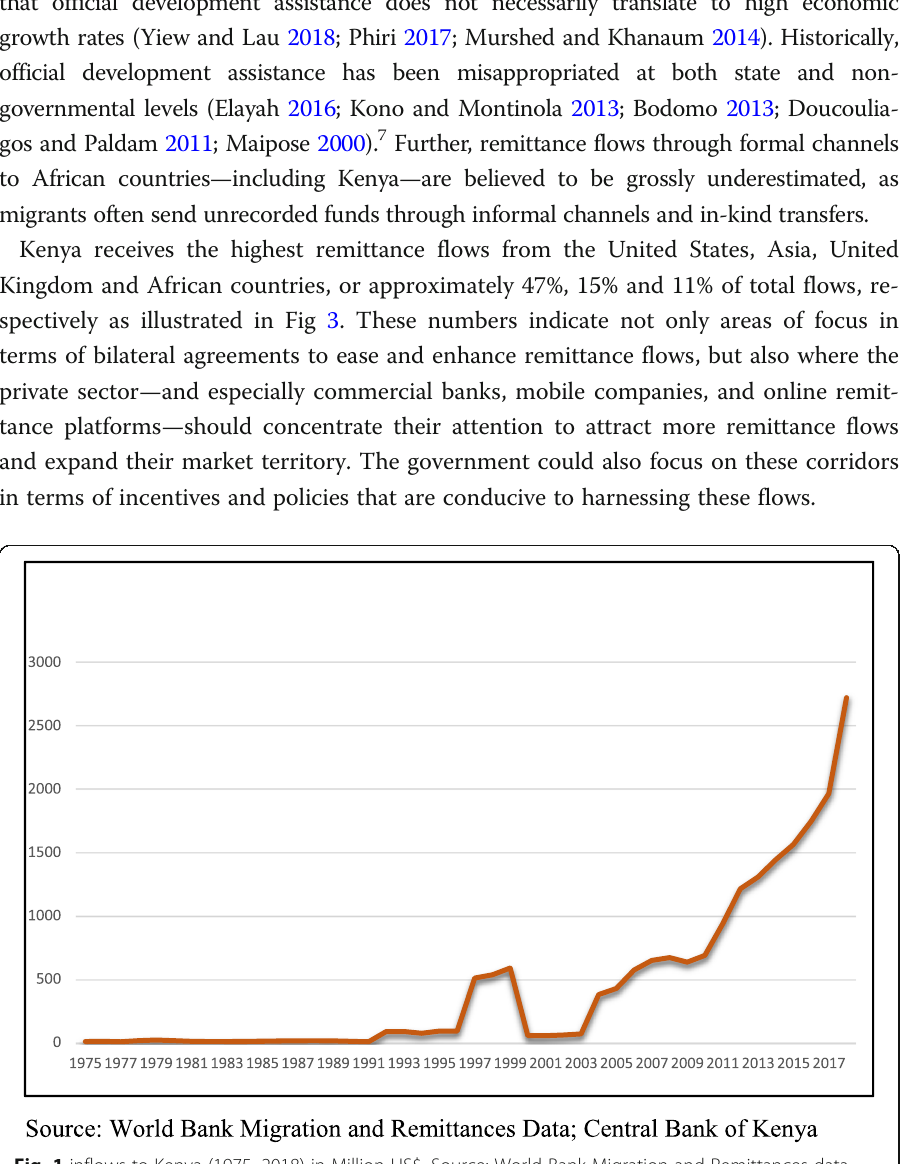
Fig. 1 inflows to Kenya (1975 – 2018) in Million US$. Source: World Bank Migration and Remittances data, Central Bank of